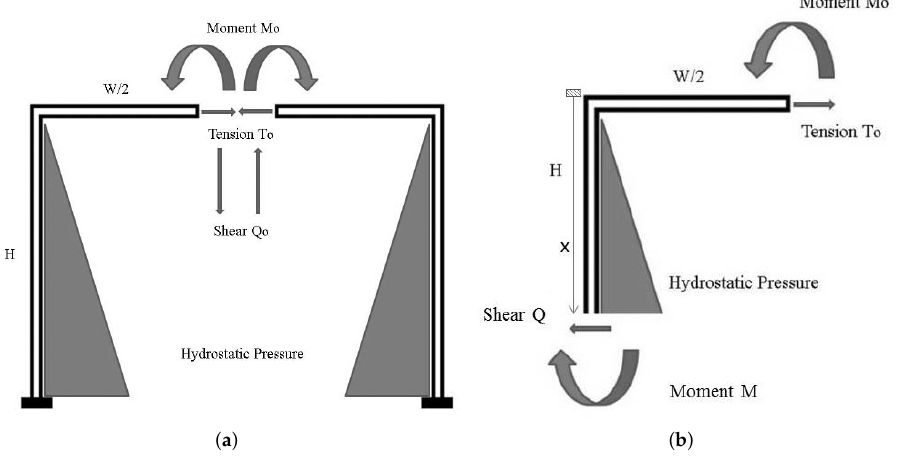
Figure 7. A simplified one and two-dimensional beam-column system model with the external pressure load along with internal forces and moments in the mid span as well as the typical vertical location with the coordinate x . ( a ) 2D column-beam model, ( b ) Moment and shear